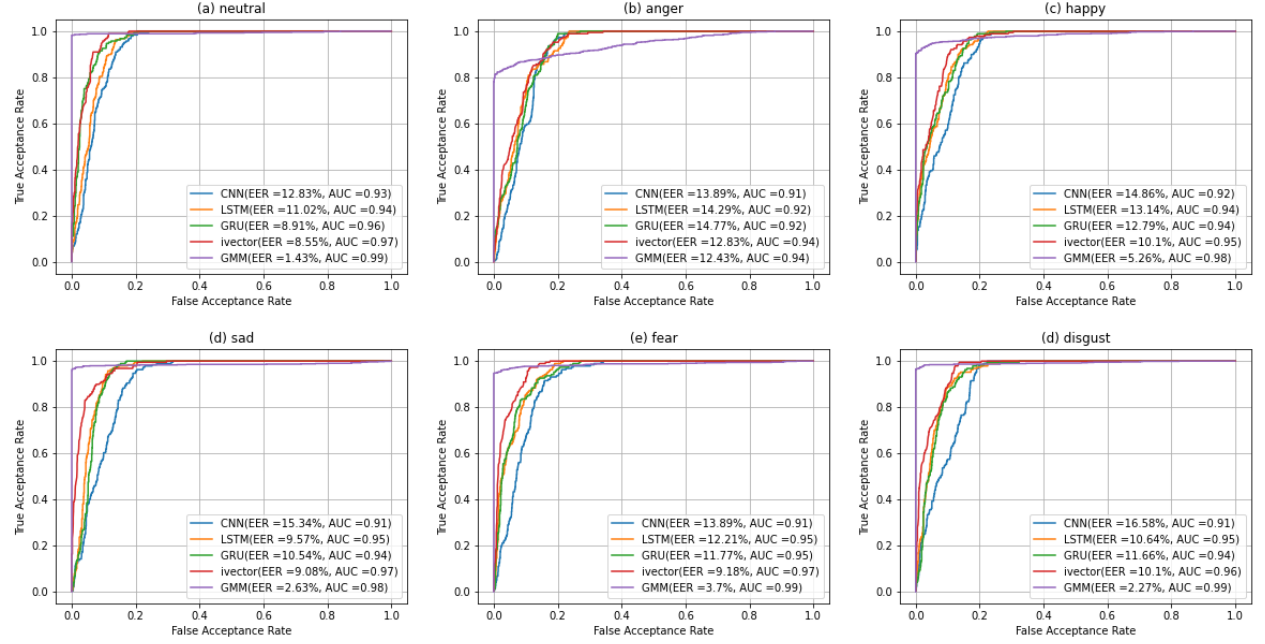
Figure 6. ROC curves with each based on GMM, KNN, SVM, ANN, CNN, LSTM, and GRU models for the different emotional states using the Emirati database. Table 3. p -value using Wilcoxon test for classical models and deep models using the Emirati